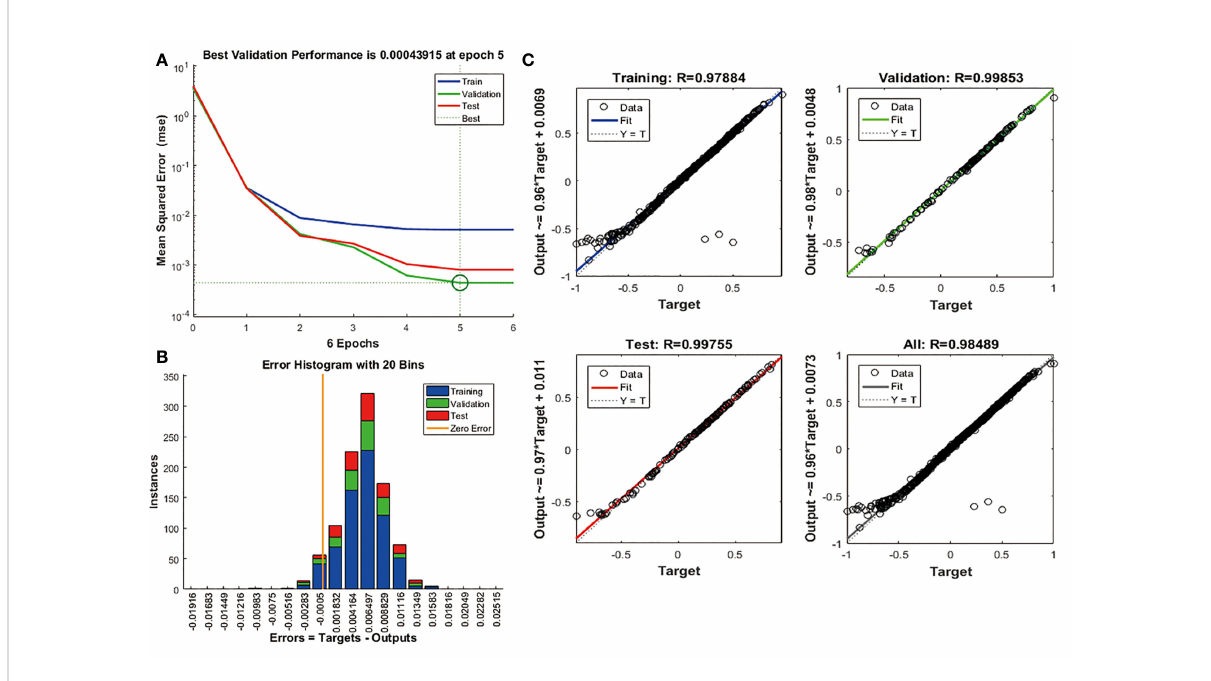
FIGURE 6 Validation of candidate features based on BPNN algorithm. (A) The change curve of MSE and epochs of the BPNN model. (B) The error distribution bar graph of the BPNN model. (C) Linear regression graph of BPNN model.